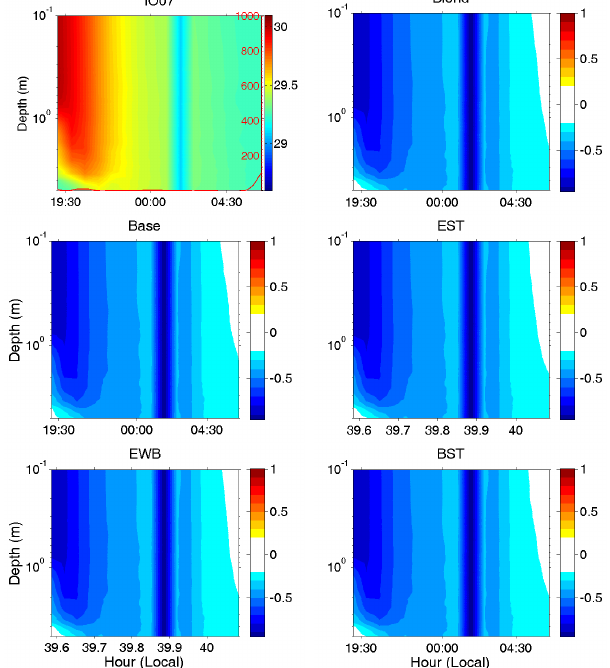
Fig. 7 : Time-series temperature depth plots for IO07 case study: observational plot and temper- Fig. 7. Time-series temperature–depth plots for the IO07 case study: ature difference (modeled minus observed) plots for the 5 model versions. Red curve represents observational plot and temperature difference (modelled minus ob- served) plots for the five model versions. Red curve represents ob- observed solar irradiance (Wm − 2 ). The white area used represents an ideal ∆ T of ± 0.2 K. served solar irradiance (Wm − 2 ). The white area used represents an ideal 1T of ±